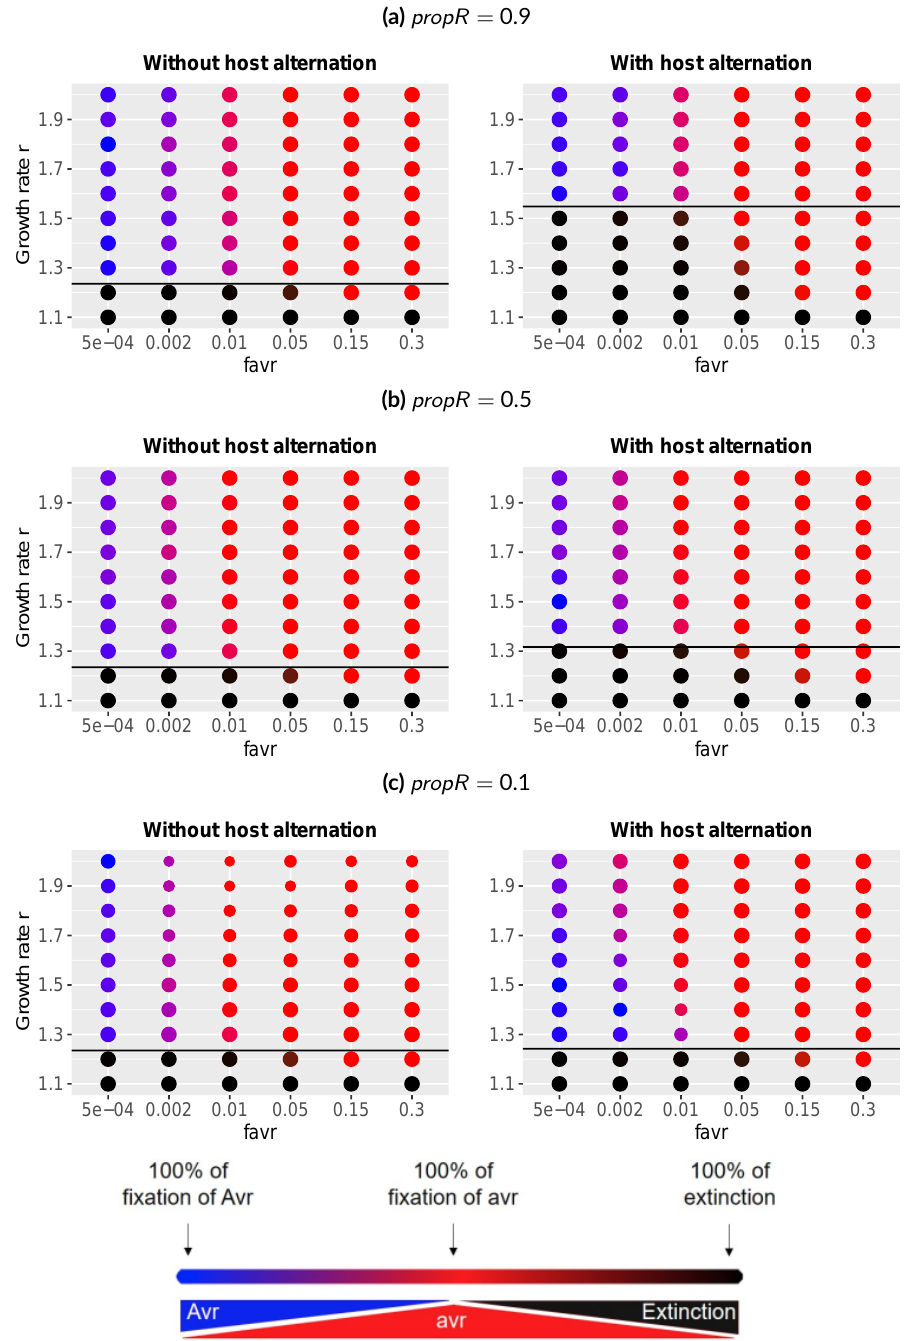
Figure 4 – For diploid pathogens, representation of the frequencies of population extinc- tion or fixation of alleles Avr or avr for each combination of four parameters: f avr , r , propR and cycle , with mig = 0.05 . On each graph the black line corresponds to the calculated value of the growth rate threshold r 0 below which the population dies if it does not ex- pand to the R compartment. The surface of each plotted result is proportional to the number of simulations, among the 100 replicates, for which an equilibrium was reached at the end of the 1100 generations